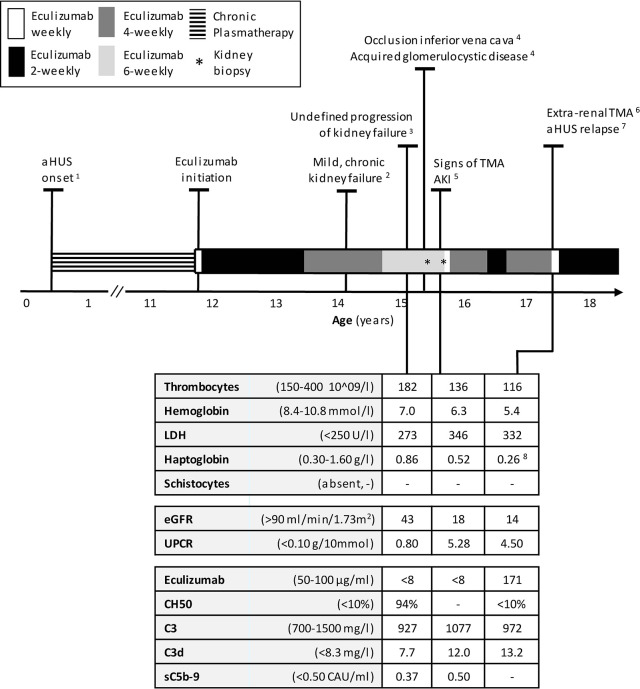
Timeline of treatment of aHUS in this patient, starting with the onset of disease at the age of 5 months until 18 years. Normal values of laboratory parameters indicated between parentheses. 1 After onset: chronic PT, including periods with plasma infusion. Every attempt to withdrawal in his first 4 years initiated a relapse. Number of relapses during PT period, n=7, 2 eGFR 65-70 ml/min/1.73m2, UPCR 0.18–0.53 g/10 mmol, 3 No thrombocytopenia, no signs of hemolysis; kidney biopsy right kidney: chronic TMA, no signs of interstitial nephritis or acute TMA,25% IFTA but diffuse small cysts eci, 4 Date of onset unknown, 5 AKI defined by a sudden increase in proteinuria and serum creatinine; kidney biopsy; similar to previous biopsy, 6 A traumatically obtained, extremely painful, and non-healing ulceration was considered as a (trigger of) an extra-renal manifestation of TMA, 7 aHUS relapse defined by AKI, thrombocytopenia and signs of hemolysis. 8 Haptoglobin decreased from 1.89 to 0,26 g/L. aHUS, atypical Hemolytic Uremic Syndrome; AKI, Acute Kidney Injury; eGFR, estimated Glomerular Filtration Rate (Schwartz formula); IFTA interstitial fibrosis and tubular atrophy; PT, Plasmatherapy; TMA, Thrombotic Microangiopathy; UPCR, Urine Protein-to-Creatinine Ratio.